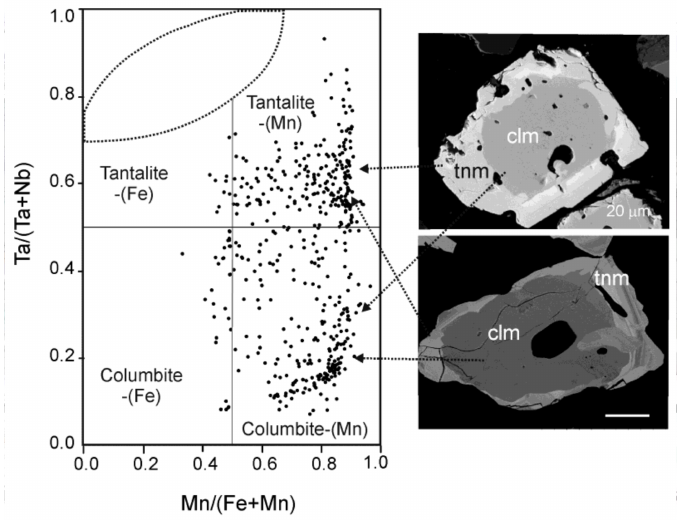
Figure 2. Chemical composition of columbite-group minerals (CGM) from the Penouta open pit in the columbite quadrilateral [35] and two illustrative scanning electron microscopy (SEM) images. Clm, columbite-(Mn); tnm, tantalite-(Mn).